Question: What visual encoding does this figure use to show its data?
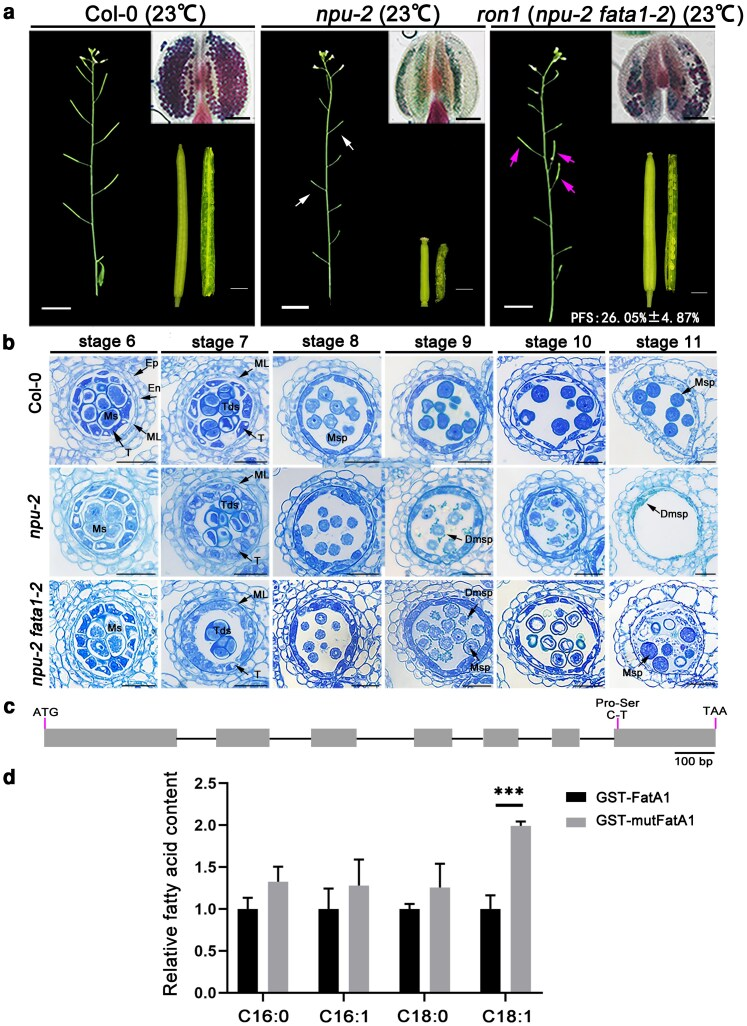
Answer: bar